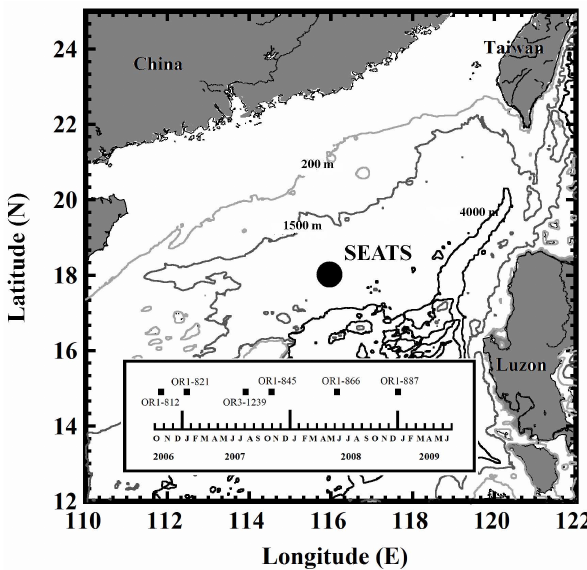
Fig. 1. Location of SEATS station in the South China Sea. Inserted box shows the timeline of the six cruises to the